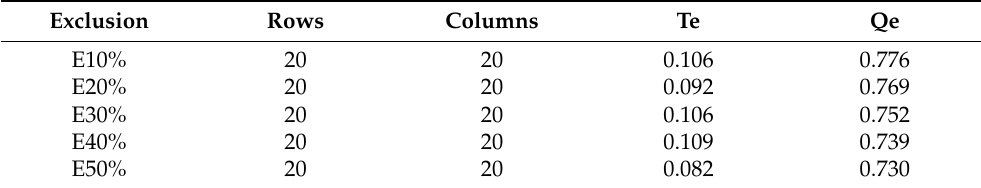
Table 3. Samples preparation and parameters for SOM